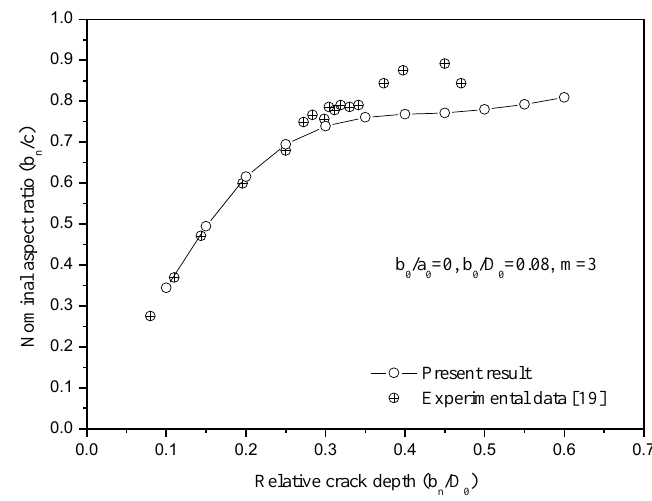
Figure 14. Crack propagation patterns compared with experimental data.